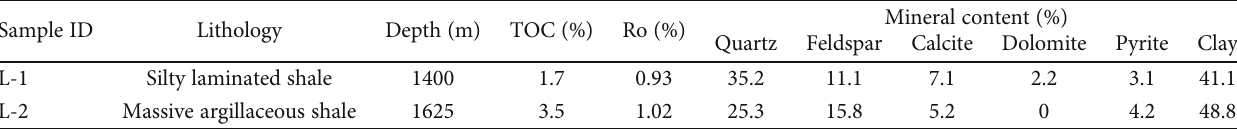
Figure 3: Photos of cores and thin sections of shale samples L-1 and L-2. (a) Silty laminated shale (sample ID L-1, 1400 m). (b) Massive argillaceous shale (sample ID L-2, 1625m). (c) Thin section images of sample L-1, showing silty laminae in silty laminated shale that can be seen by naked eyes. (d) Thin section images of sample L-2, showing argillaceous shale without silty laminae. Table 1: Mineral composition and geochemical characteristics of the Yanchang shale